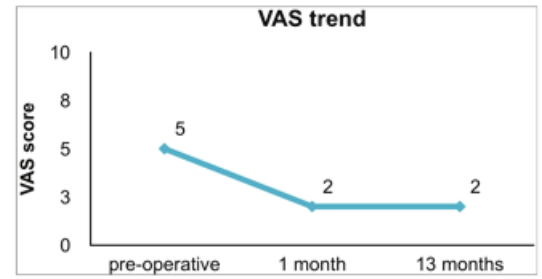
Figure 14: The properly healed wound of the lateral aspect of heel after the procedure.